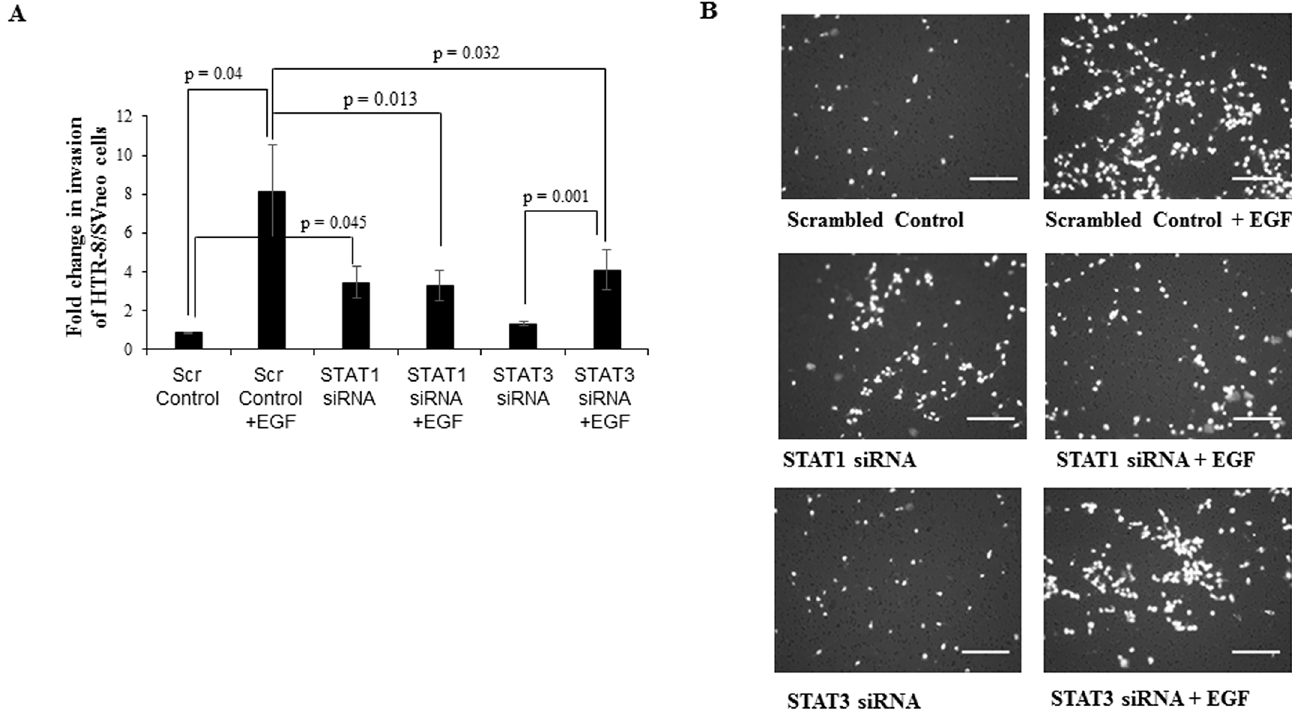
Fig 7. Effect of STAT3 and STAT1 silencing on invasion in presenceor absence of EGF. FollowingSTAT1 and STAT3 silencingin HTR-8/SVneo cells using respectivesiRNA, invasionassay was performed either in presence or absenceof EGF (10 ng/ml) as describedin Materials and Methods . Panel A shows relative fold changein invasionfollowingEGF treatment of scrambledsiRNA, STAT1 siRNA and STAT3 siRNA transfected cells as comparedto the untreatedHTR-8/SVneo cells. Valuesare expressedas mean ± SEM of three independentexperiments performed in duplicates. Panel B has representative photographsof invadingcells in EGF treated scrambledsiRNA, STAT1 siRNA and STAT3 siRNA transfected cells and the respectivecontrols on 0.8 μ m pore size transwellmembranes as observed under microscope (10X objective) after processingfor invasionassay. Scale bar represents5 μ